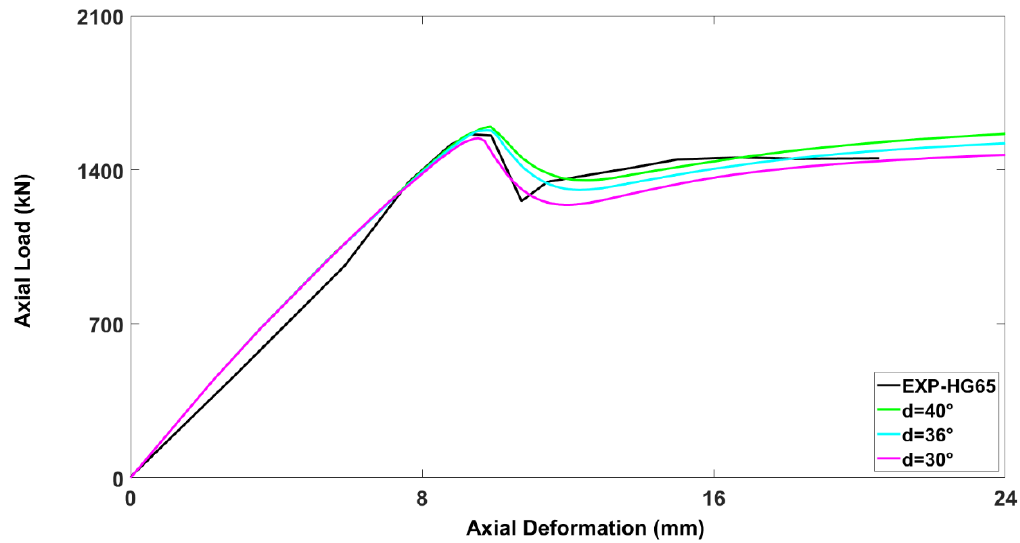
Figure 8. Calibration of control specimen (HG-65) for dilation angle.